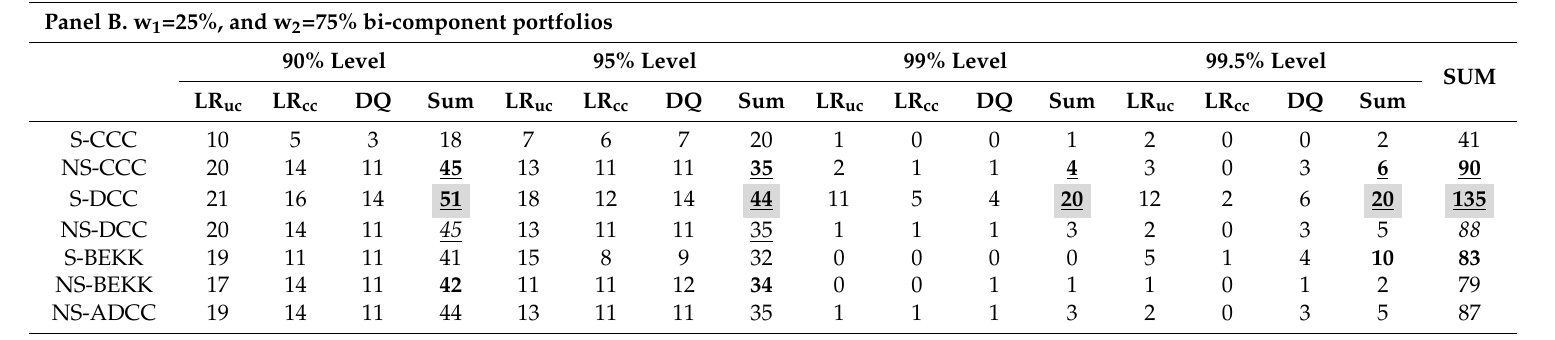
Panel B. w 1 =25%, and w 2 =75% bi-component